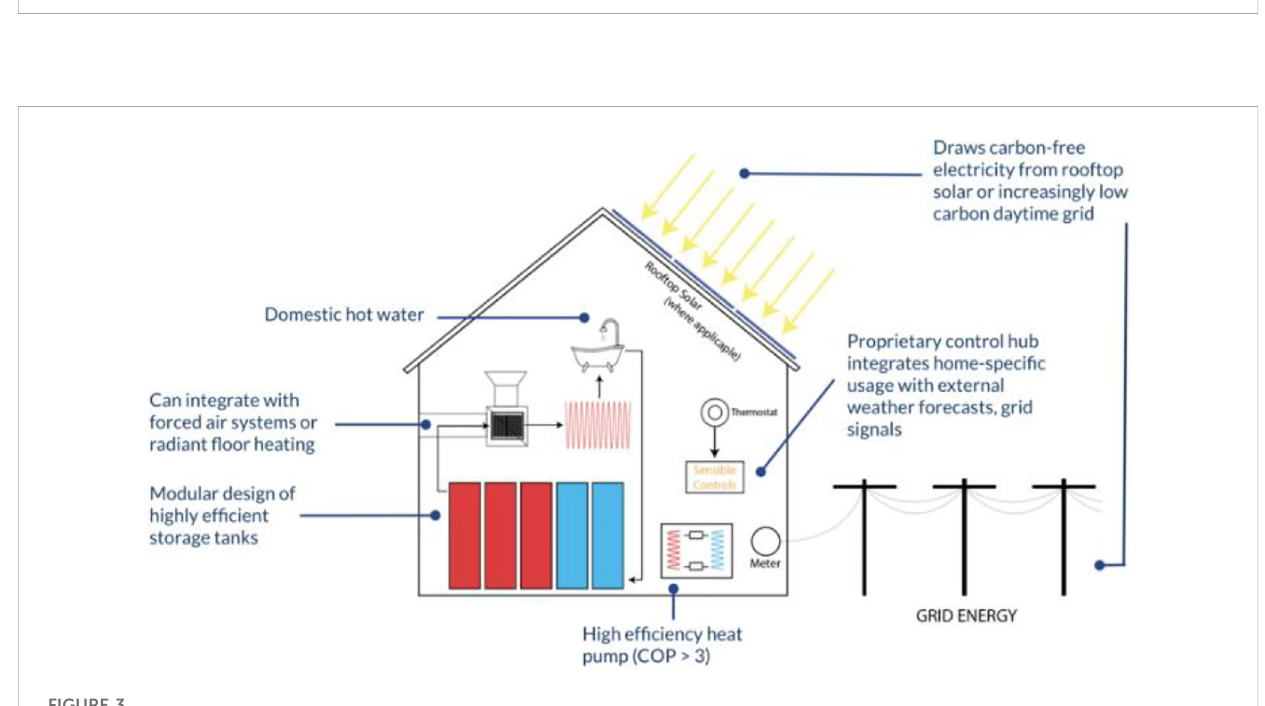
FIGURE 3 Sensible thermal energy storage